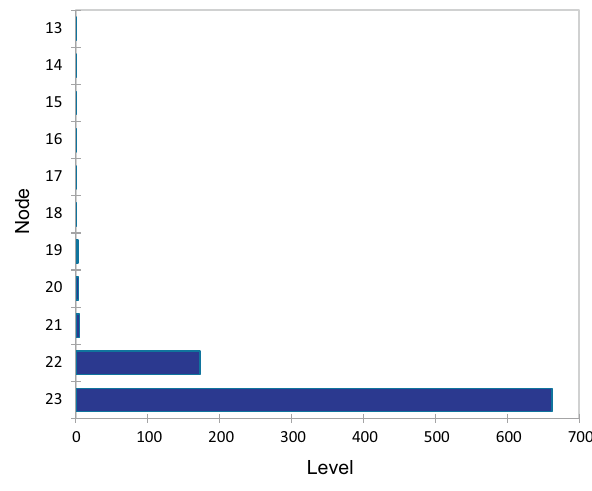
Fig. 13 Levels bar chart of the agglomerative hierarchical cluster analysis